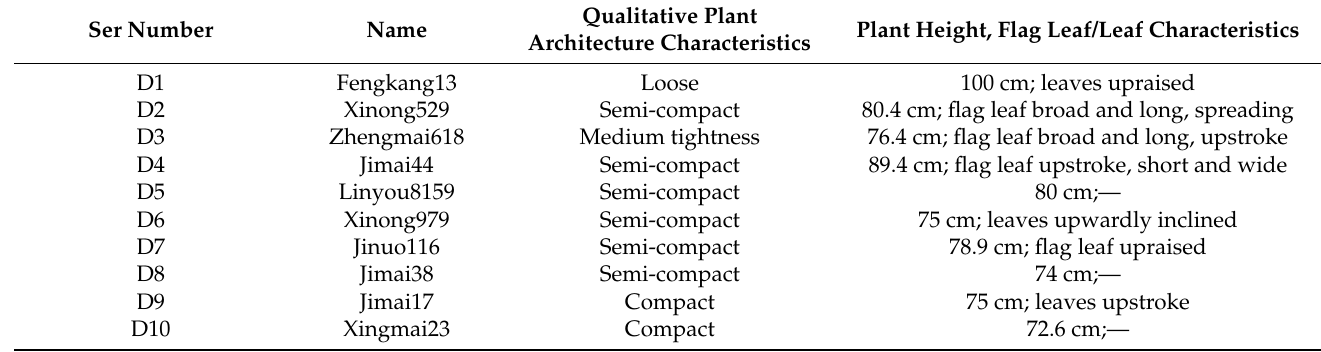
Table 1. The cultivars used in the test and their plant architecture